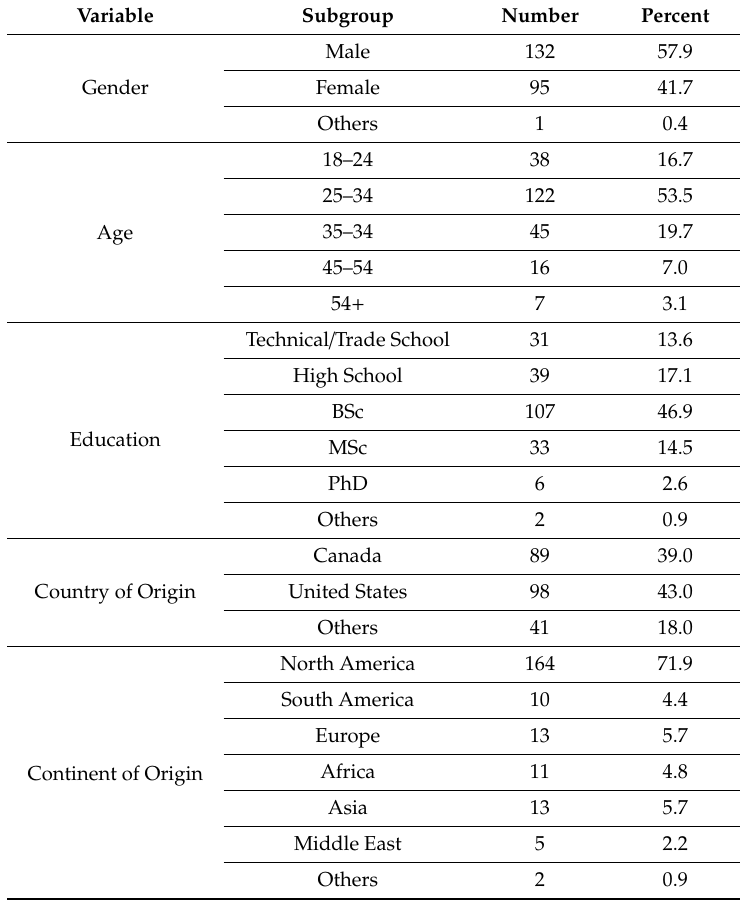
Table 3. Demographics of participants (n =